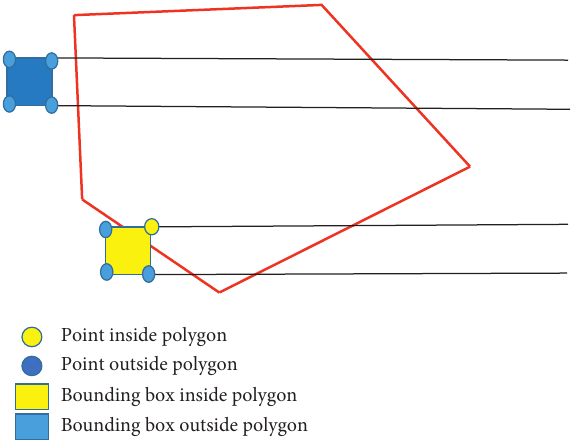
Figure 6: The mechanism is used to check whether a bounding box is inside ROO or not.